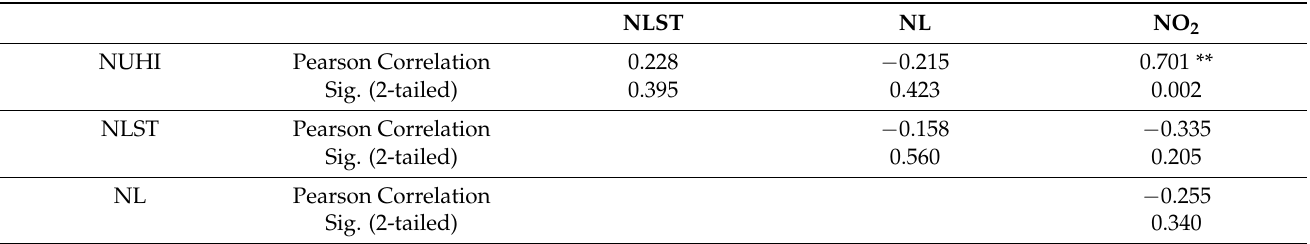
Table 9. Correlation matrix: Correlation between NUHI, NLST, NL, and NO 2 changes in each of the studied